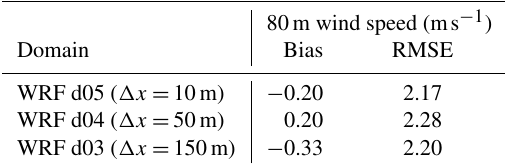
Table A1. Eighty-meter wind speed bias and RMSE between WRF–LES–GAD on domains d03, d04, and d05 and SW_TSE04 tower measurements for the convective case study from 13:00–